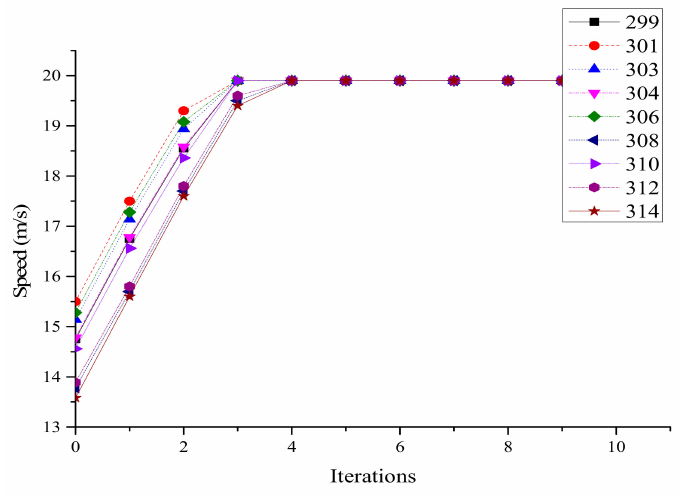
Figure 6. Optimized vehicle speed on lane 2.